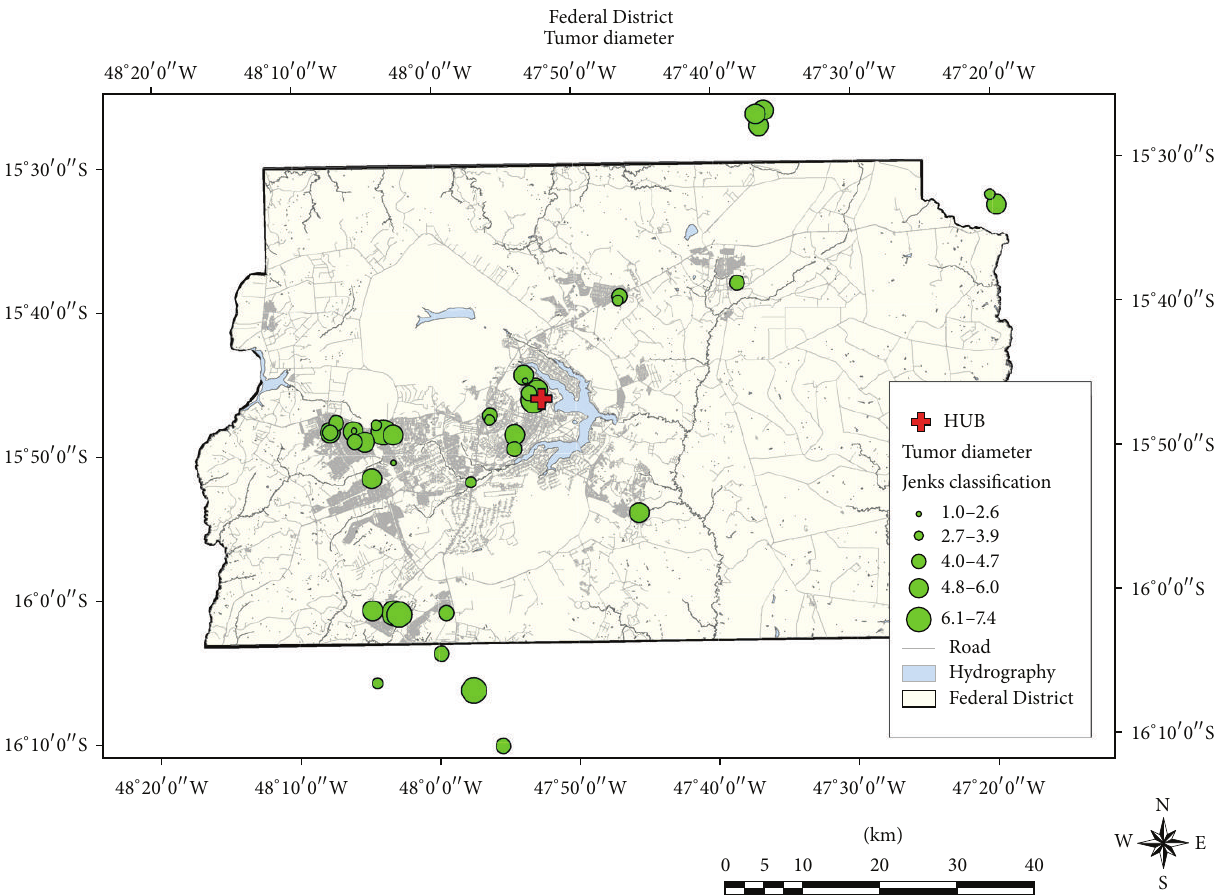
Figure 4: Geographic distribution of natural breaks classification results of tumor size, using Jenks classification.